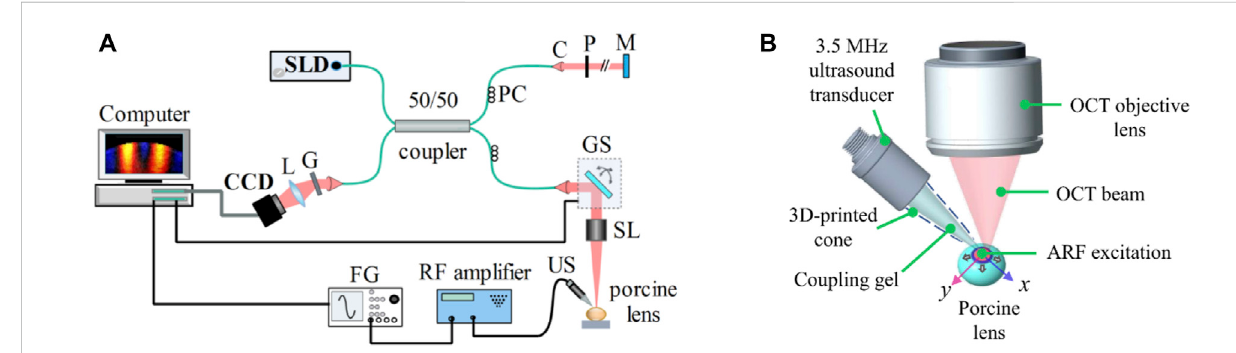
FIGURE 1 (A) Schematic of the experimental setup comprising a phase sensitive spectral domain OCT system for imaging and acoustic radiation force system for excitation. C: collimator, CCD: charge-coupled device (line scan camera), FG: function generator, G: grating, GS: 2D galvo scanner, L: lens, M: reference mirror, P: pinhole, PC: polarization controller, SL: scan lens, SLD: superluminescent diode, US: ultrasound transducer. (B) Ultrasound transducer producing acoustic radiation force excitation at the apex of the lens. Propagating elastic waves were imaged and analyzed along the orthogonal x and y